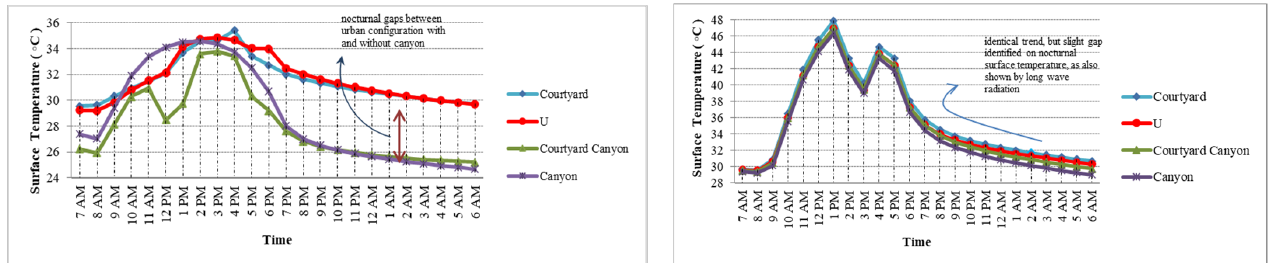
Figure 10. Surface temperature vs. time at FBTS (left ) and SM ( right ).